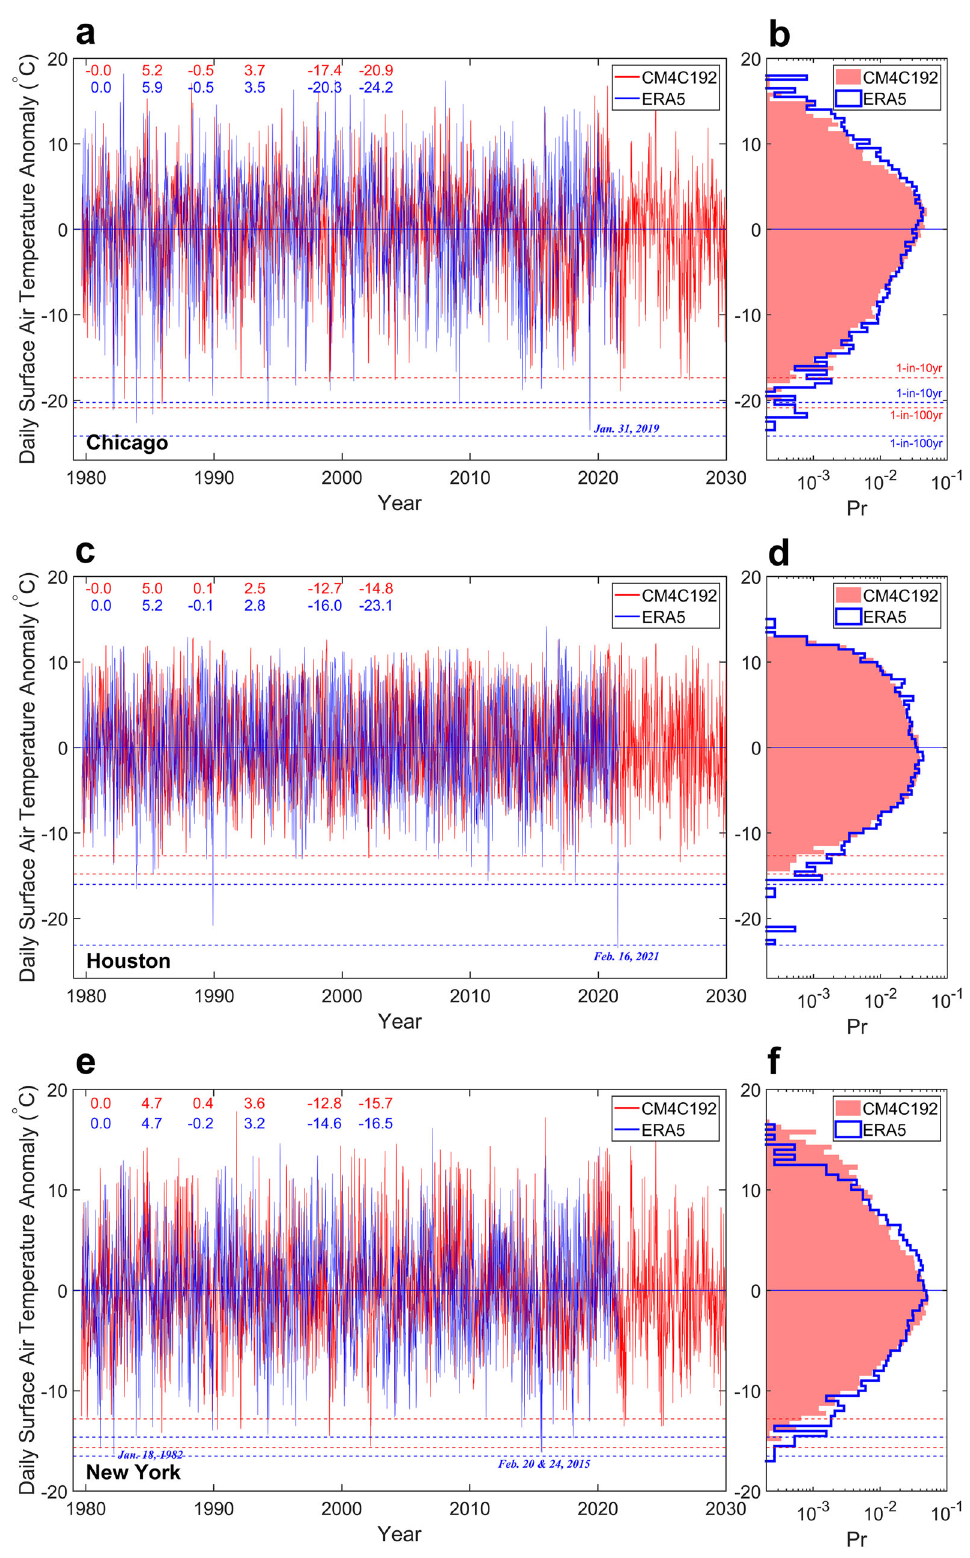
Fig. 3 Data-model comparison of DJF daily temperature anomalies ( Δ T s ) at three cities of the U.S. a , b Chicago; c , d Houston; e , f New York. a , c , e The time series for 1979 – 2021 of ERA5 and the 50-year control simulation of CM4C192. Both curves are detrended and deseasonalized so that the mean is zero. The coldest value of Δ T s at each city in ERA5 is marked with its occurrence date. b , d , f The histograms of the 42-year ERA5 data and the 100-year control simulation of CM4C192. Note that the x -axis uses a logarithmic scale and denotes probability ( c i / N ; c i — bin count; N — total count). The solid horizontal lines show the mean. The dashed horizontal lines denote the return levels for the 1-in-10-year and 1-in-100-year cold events. Their values along with the mean and three moments of the time series are listed at the upper left corner. From left to right: mean, standard deviation, skewness, kurtosis, 100 c Δ T 10 , and c Δ T s s